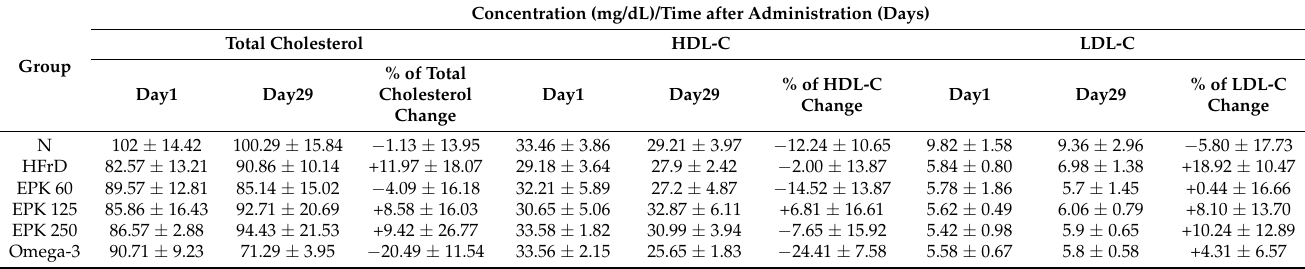
Table 3. Serum lipid markers in experimental